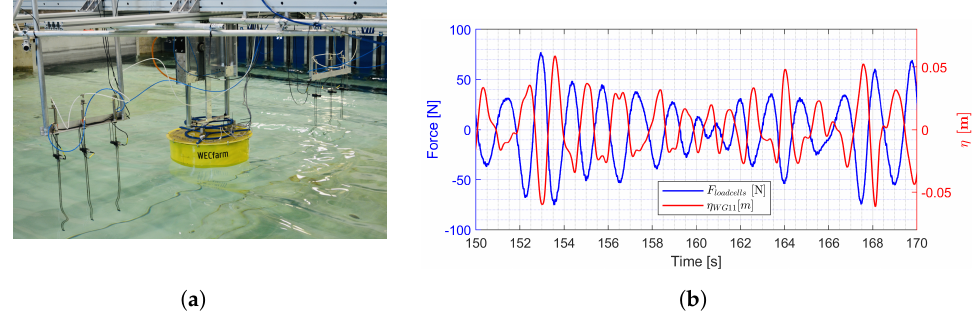
Figure 12. Excitation test: ( a ) Picture of the setup in the AAU wave basin; ( b ) F loadcells and η WG 11 time series (Test_074).